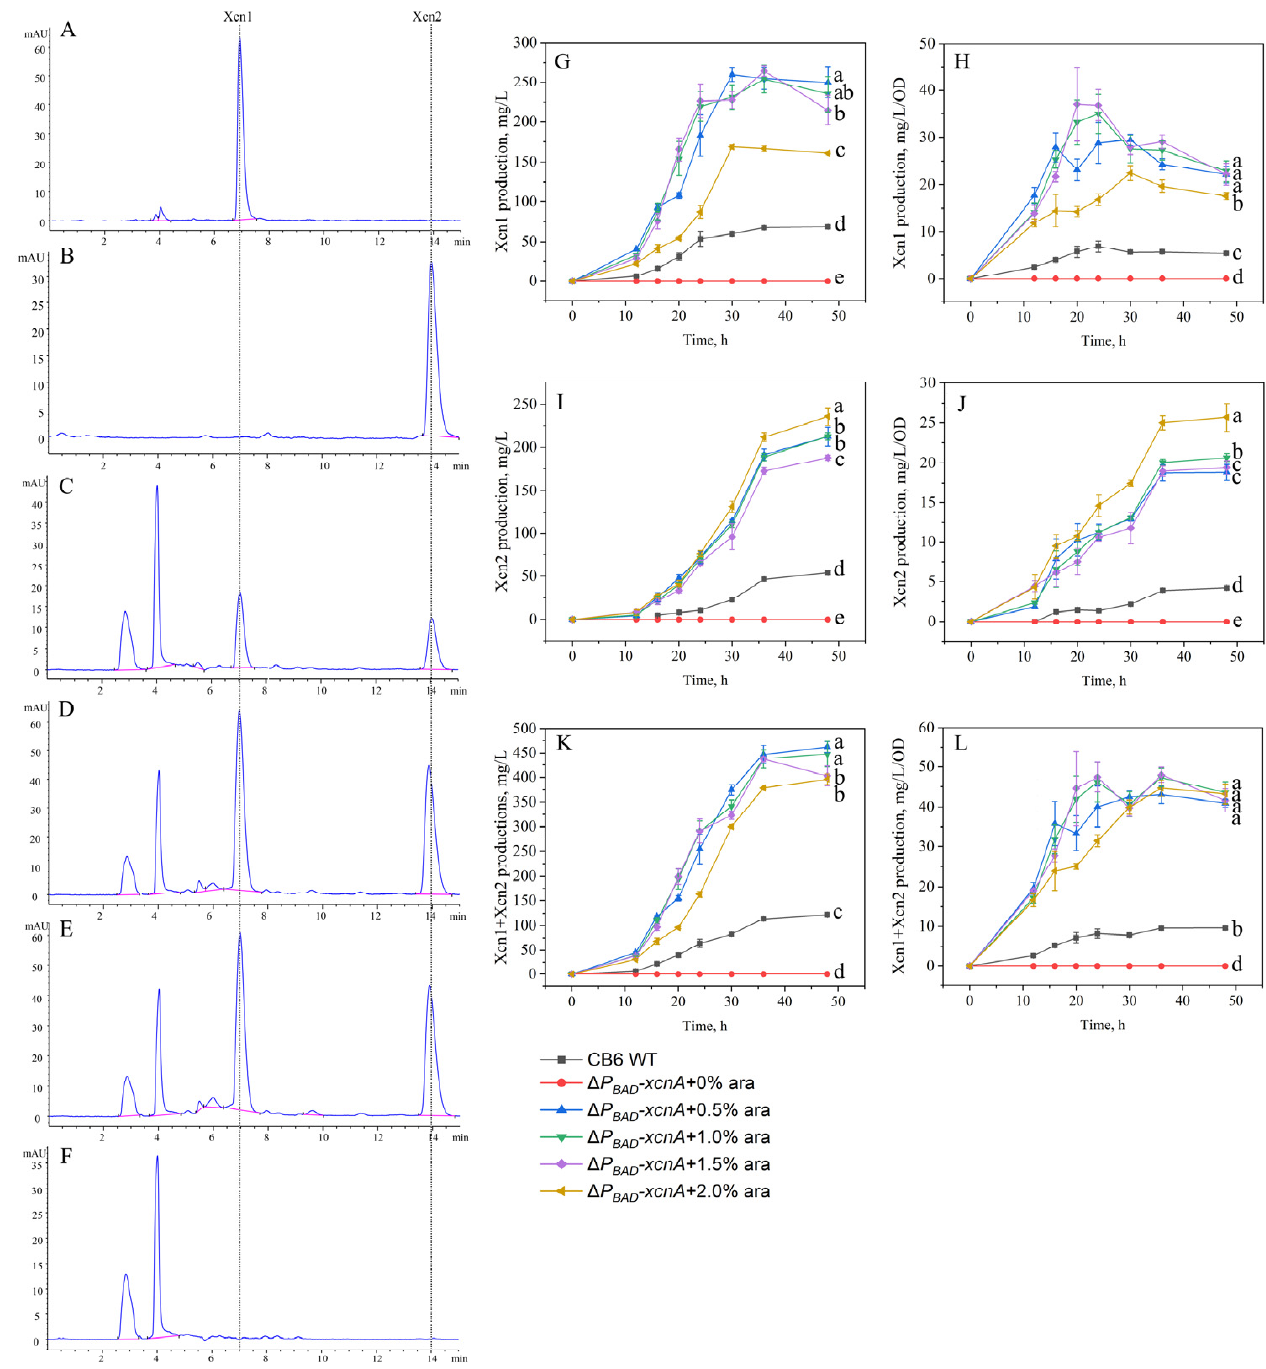
Figure 3. HPLC chromatogram of fermentation samples at 48 h and the dynamic curve of Xcn1 and Xcn2 detected by HPLC during the fermentation process. ( A ) Xcn1 standard (100 µ g/mL), ( B ) Xcn2 standard (100 µ g/mL), ( C ) fermentation sample of WT CB6, ( D ) fermentation sample of ∆ P BAD - xcnA mutant induced by 0.5% L-arabinose, ( E ) fermentation sample of ∆ P BAD - xcnA mutant induced by 2% L-arabinose, ( F ) fermentation sample of uninduced ∆ P BAD - xcnA mutant, ( G ) the dynamic curve of Xcn1, ( H ) the dynamic curve of Xcn1 per OD, ( I ) the dynamic curve of Xcn2, ( J ) the dynamic curve of Xcn2 per OD, ( K ) the dynamic curve of Xcn1+Xcn2, and ( L ) the dynamic curve of Xcn1+Xcn2 per OD. Error bars represent the standard deviation of three independent replicates. Data were subjected to the Duncan ANOVA test, curves labelled with different lowercase letters at 48 h were significantly different at p ≤ 0.05. 3.4. Transcriptional Analysis of the Xcn Genes To evaluate the xcn genes’ transcription levels of the Δ P BAD -xcnA mutant in different L-arabinose concentrations, qRT-PCR was employed to monitor the four critical genes ( xcnA , xcnF , xcnG, and xcnM ) during the fermentation process (Figure 4). Consistent with our expectations, induced by L-arabinose, all of the four genes in the Δ P BAD -xcnA mutant showed higher transcription levels relative to the wildtype CB6 strain at both 24 h and 36 h. It is worth noting that the expression levels of xcnA , encoding the important NRPS en- zyme responsible for Xcn1 biosynthesis, in the Δ P BAD -xcnA mutant were enhanced 7-fold,